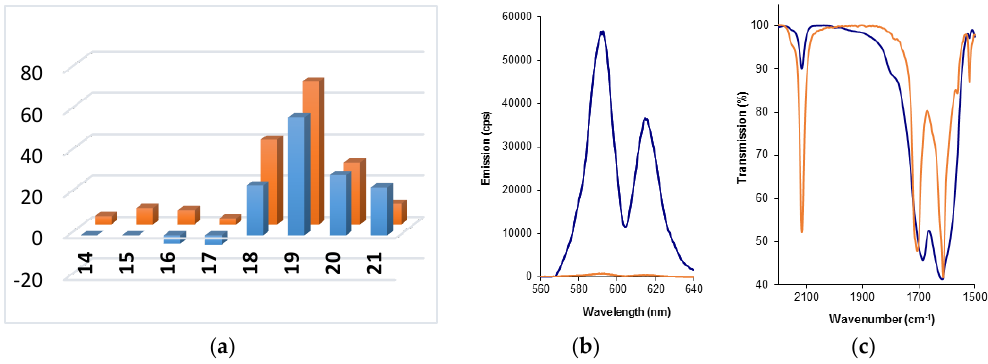
Figure 3. Change in Signal Output after CuAAC Reaction: ( a ) Sensor-Ln complex (Front (blue): Tb; Back (orange): Eu) vs. Signal increase over background (fold); ( b ) Luminescence of crude sensor 19-Eu (blue) and background 1a : 11 (1:1) (orange), showing a 69-fold increase in emission (measured at 100 µ M in H 2 O, time delay = 0.076 ms, slits = 10 nm, sample window = 5 ms, number of flashes = 20); ( c ) FT-IR analysis of azide peak at 2100 cm −1 for crude sensor 19-Eu (blue) with normalization of absorbance to carbonyl band at 1612 cm −1 in a 1:1 mixture of 1a : 11 (orange).